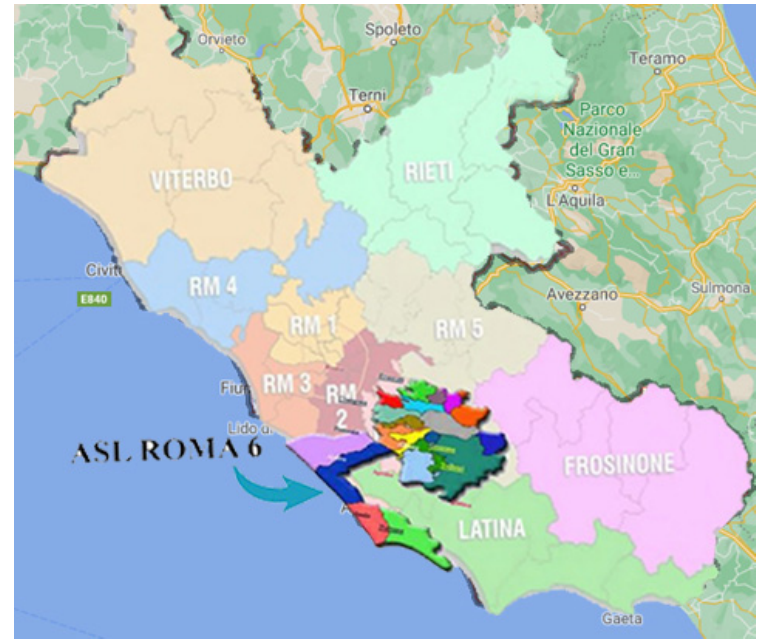
Figure 1. Health authority districts of Lazio region. The figure shows the geographical location of the Rome 6 ASL (in vivid colors) in the context of the Lazio Region and the relationship with the other ASLs.